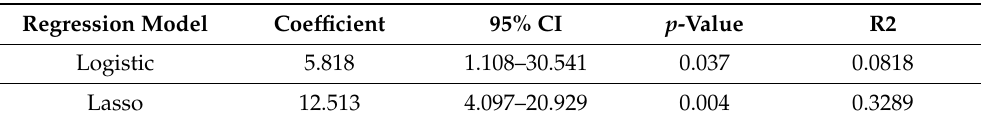
Table 4. Comparation between regression model of 25-OH vitamin D deficiency as a predictor of severe